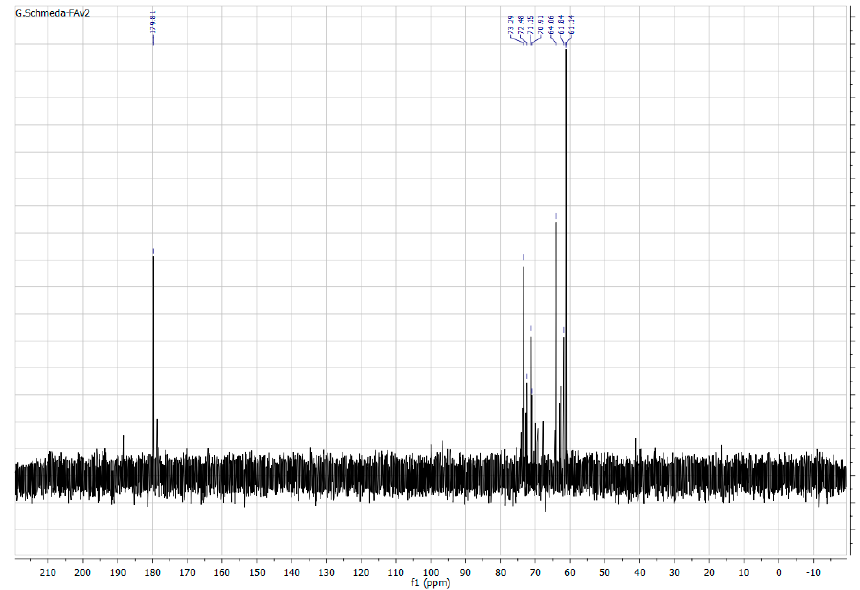
Figure 5. 13 C-NMR spectrum of the fraction showing the chromophore in UV/vis. While neither aromatic C nor conjugated double bonds are detected, the spectrum showed the oxidation product of glucose.